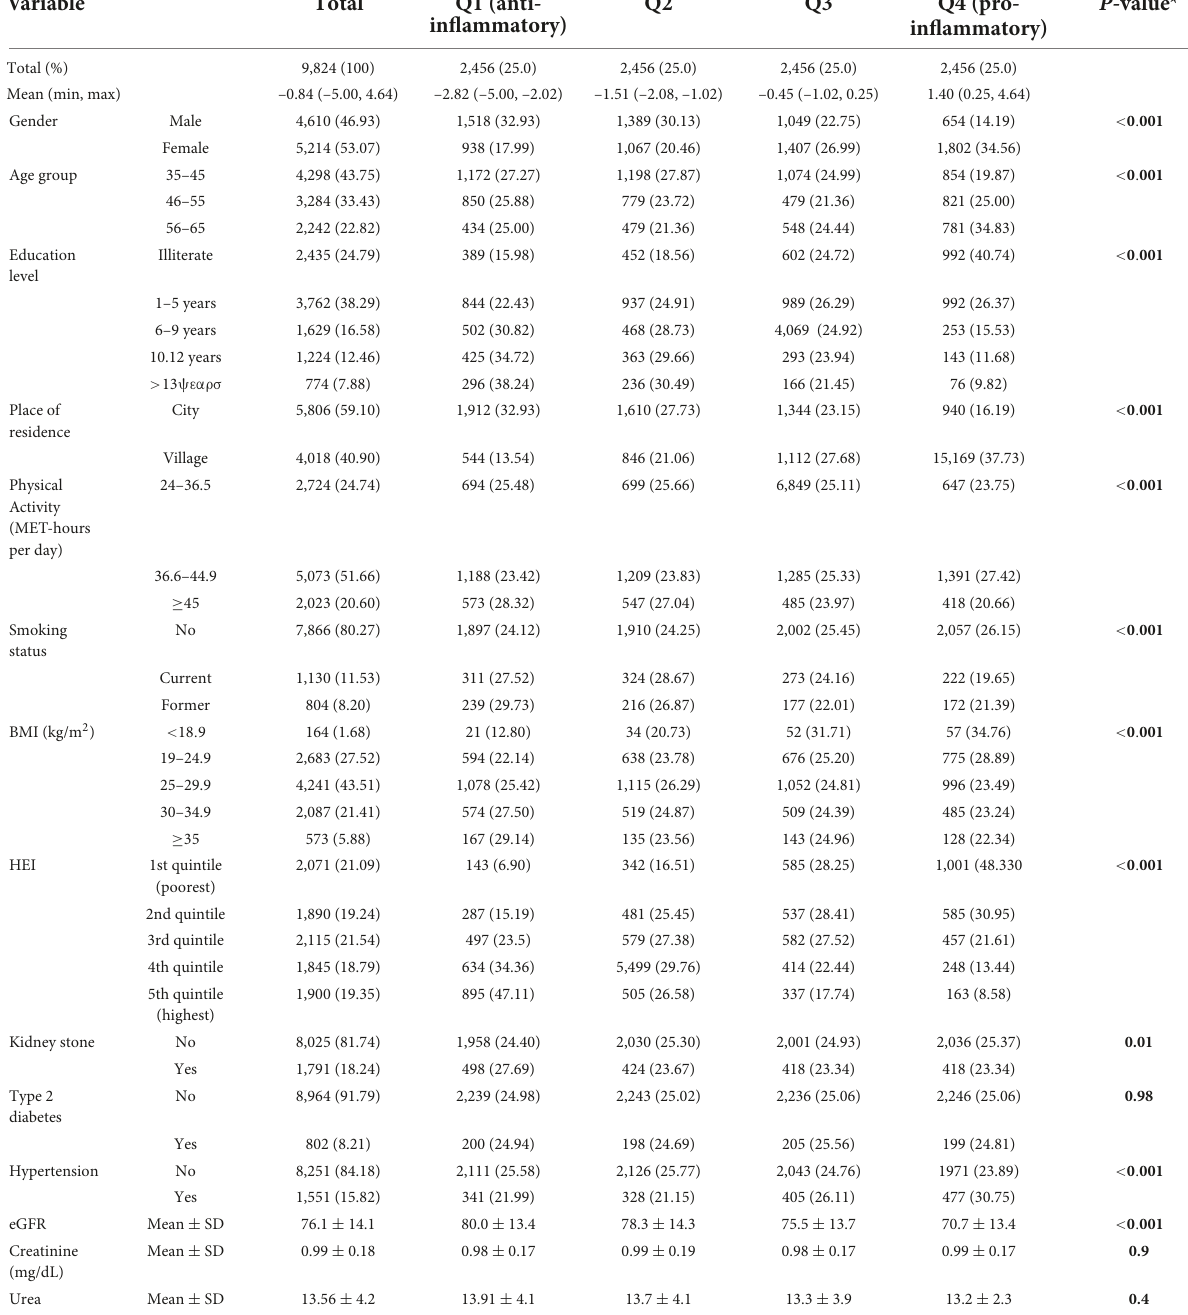
TABLE 1 Characteristics of the participants according to the quartiles of dietary inflammatory index.